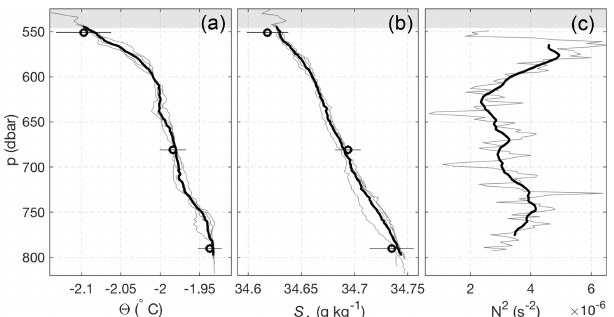
Figure 2. (a) Conservative temperature ( (cid:50) ) and (b) Absolute salin- ity ( S A ) profiles from the two CTD casts at AM06. Individual up and down casts are shown (grey lines), with the four-profile mean also shown (black line). Overlain at the appropriate pressures are the mean ( ± 2 σ ) MicroCAT (cid:50) and S A for the month following the CTD data collection. (c) Squared buoyancy frequency ( N 2 ) profiles, where the grey and black buoyancy frequency curves were obtained using 10 and 40dbar running window averages, respectively. The shaded grey region shows range in the ice–ocean interface position above the instruments due to the sloping ice